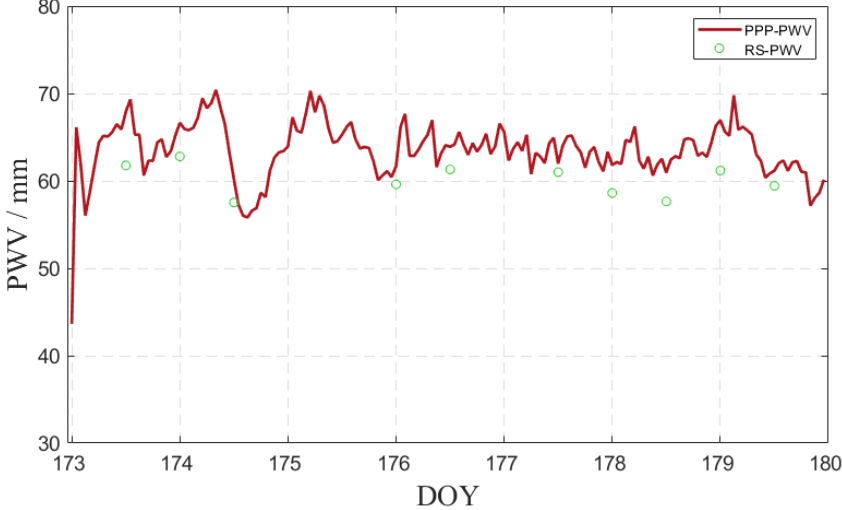
Figure 6. Comparison of PPP PWV between HKSC station and radiosonde station during rainfall. Table 7. Bias, STDEV, and RMS between PPP PWV and radiosonde station PWV.